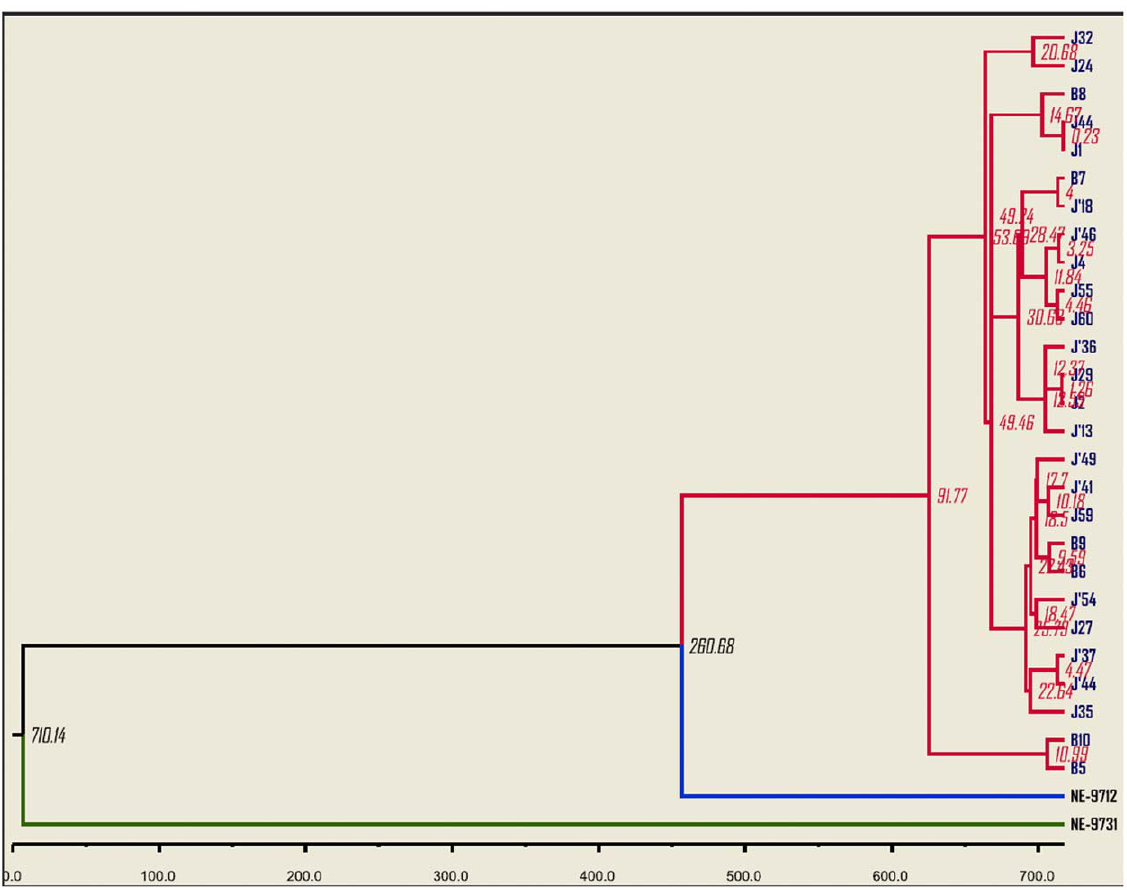
Figure 7. Maximum clade credibility tree based on segment 12 of LNV-1 and LNV-2 prototype isolates and including the 27 LNV isolates obtained from mosquitoes in 2005. The axis shows the estimated dates for most recent common ancestors as years before 2005. NE- 9712 (LNV-NE9712) and NE-9731 (LNV-NE9731) are prototype strains of LNV serotypes 1 and 2, respectively. Values at the nodes are those for the most recent common ancestor of segment 12.